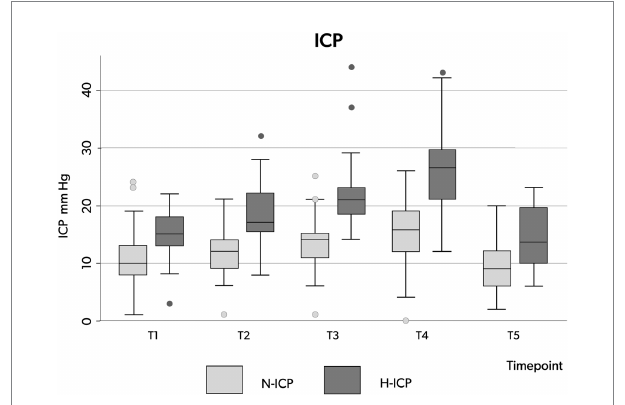
FIGURE 3 Box plots illustrating the distribution of ICP values (minimum value, first quartile, median, third quartile, and maximum value) at the five time points in patients presenting with N-ICP (light gray boxes) and H-ICP (dark gray boxes). ICP, intracranial pressure; N-ICP, normal intracranial pressure; H-ICP, high intracranial pressure.